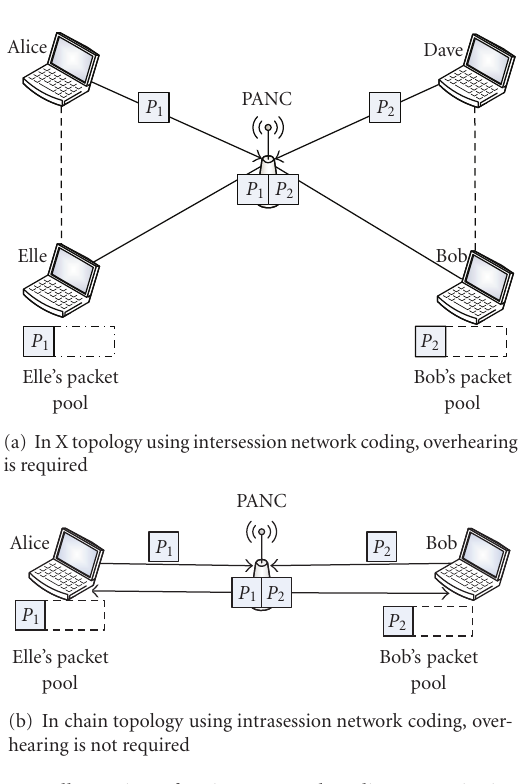
Figure 3: Illustration of various network coding strategies in wire- less